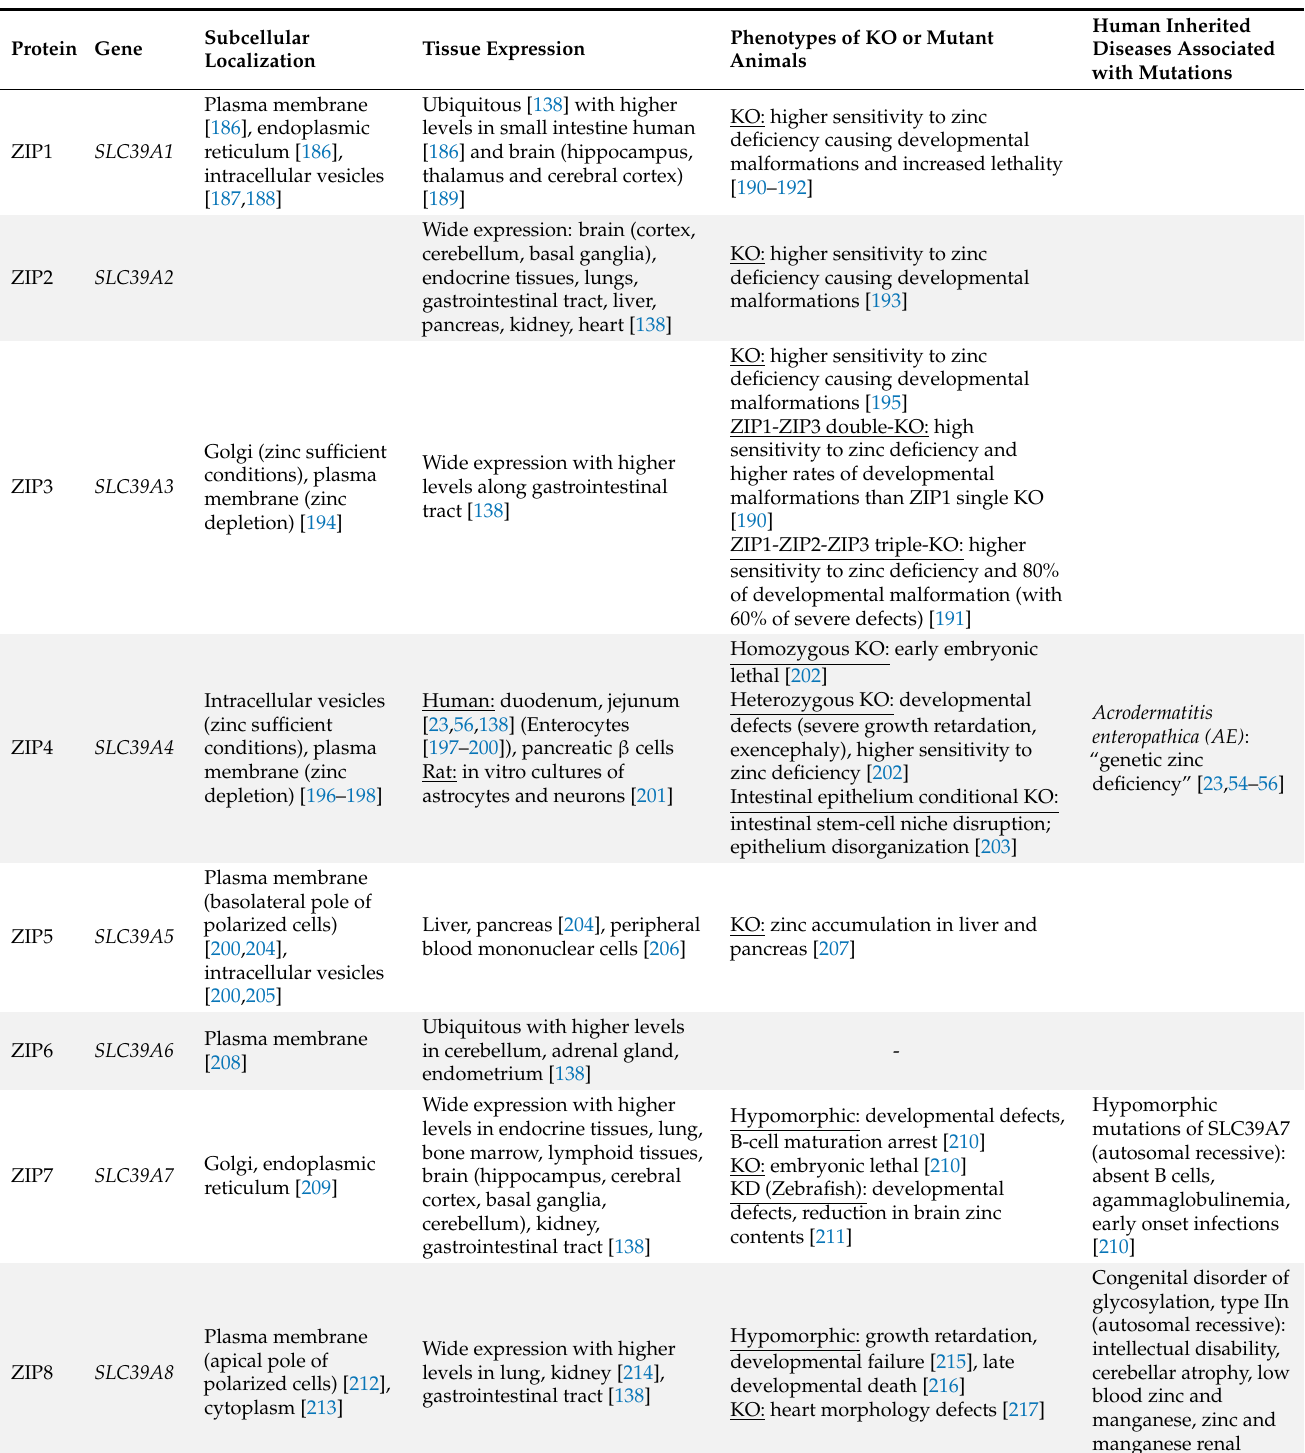
Table 4. Mammal ZIP proteins, phenotypes of KO or mutant animals and human inherited disorders associated with their